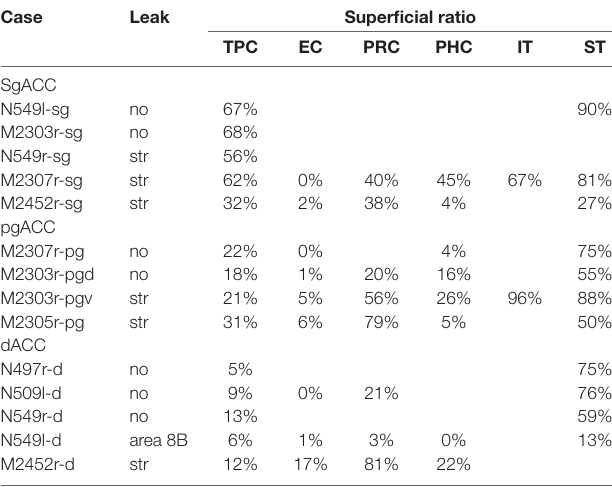
TABLE 2 | Ratios of labeled neurons in the superficial layers.